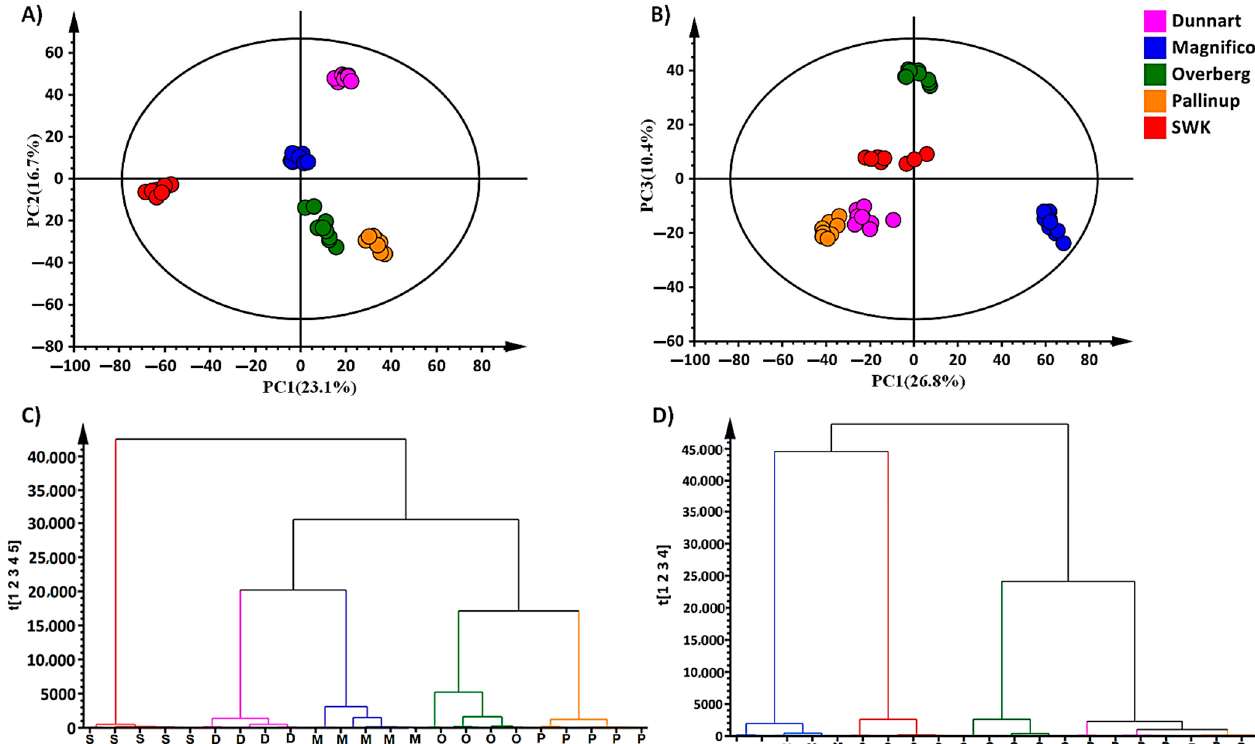
Figure 3. Principal component analysis (PCA) of five oat cultivars with the corresponding hierarchical cluster analysis (HiCA) dendrograms. PCA score plots indicate the clustering and general grouping among the five cultivars (Overberg— O, Pallinup—P, Dunnart—D, Magnifico—M, and SWK001—S) extracted from ( A ) leaf and ( B ) root tissues, analysed in ESI(–) mode. The HiCA dendrogram ( C ) shows the hierarchical structure of the leaf data indicating that ‘Pallinup’ is phytochemically more similar to ‘Overberg’, and ‘Dunnart’ to ‘Magnifico’. In comparison, ‘SWK001’ is the most different from the other cultivars concerning their leaf metabolic profiles. The HiCA dendrogram ( D ) illustrates the root metabolic profiles; ‘Pallinup’ and ‘Dunnart’ are similar and cluster closely with ‘Overberg’. In comparison, ‘Magnifico’ and ‘SWK001’ are metabolically different from the other three cultivars based on the extracted profiles.